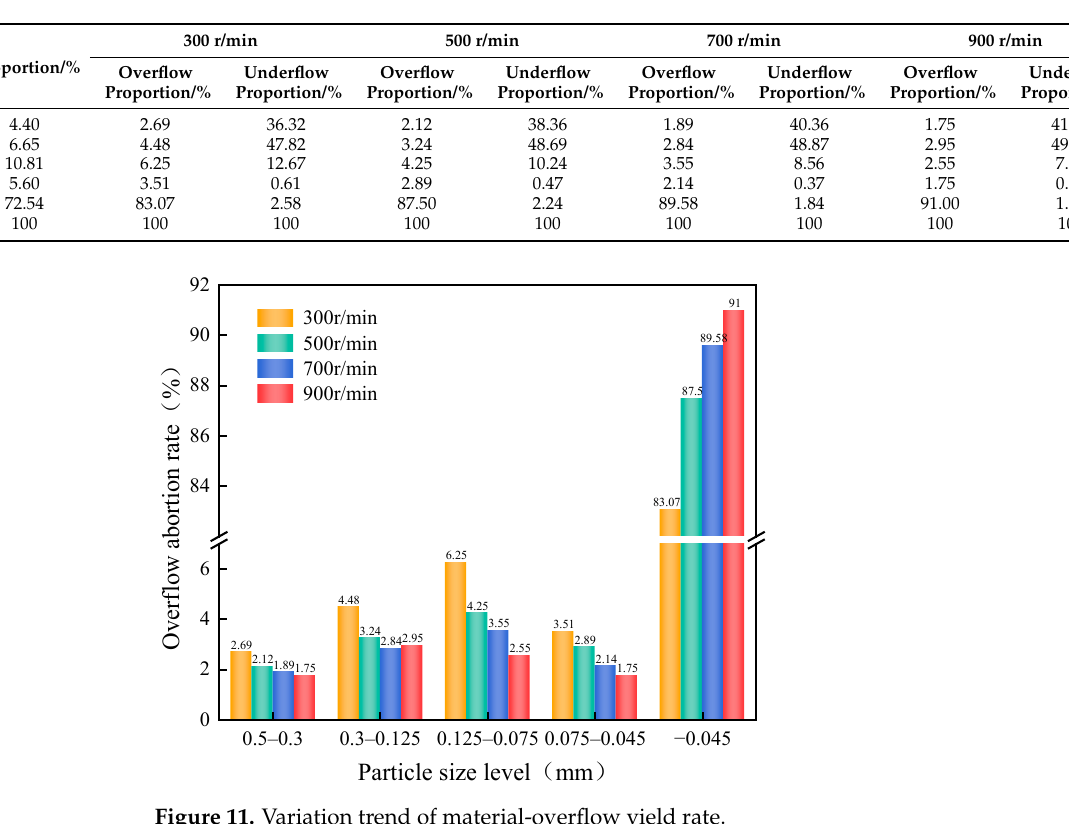
Table 4. Separation results of materials at different rotational speeds.